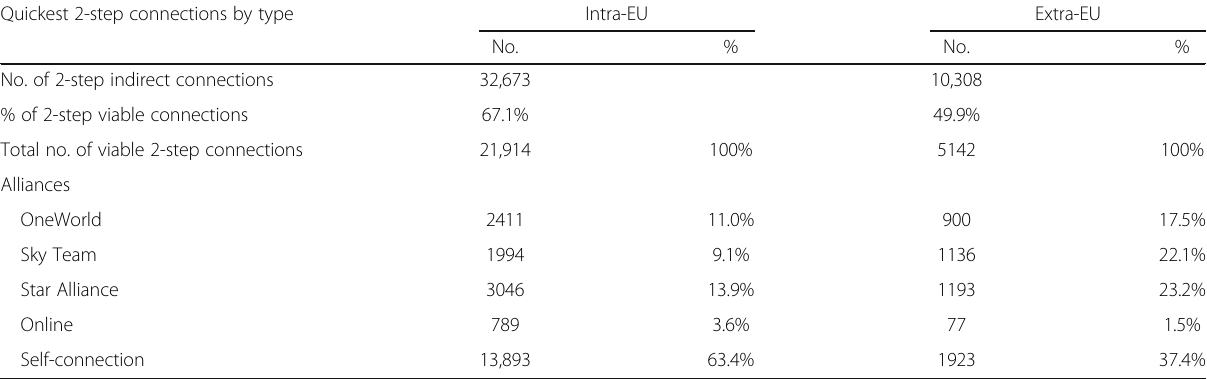
Table 2 Number of quickest 2-step connections by type of connections and for geographical areas Quickest 2-step connections by type